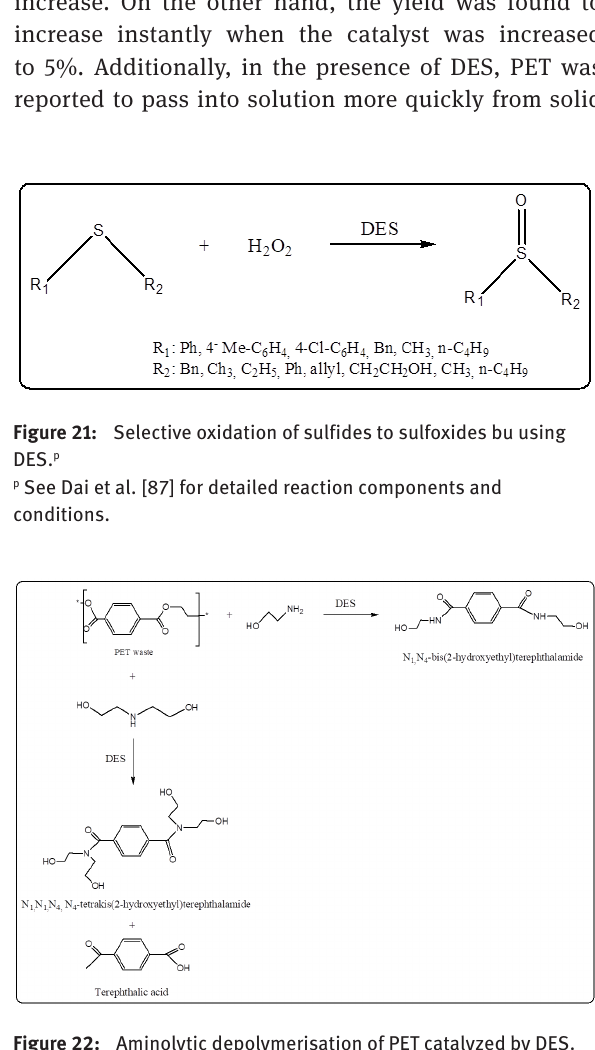
Figure 22: Aminolytic depolymerisation of PET catalyzed by